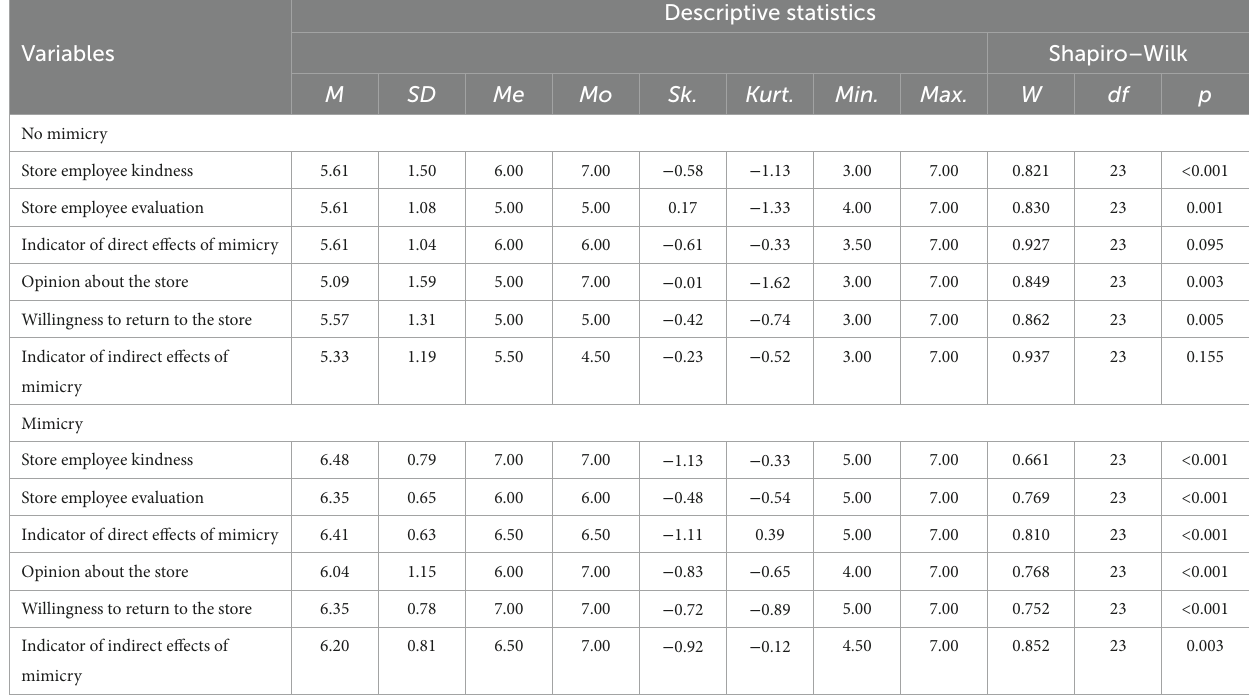
TABLE 1 Descriptive statistics of all study variables within the no mimicry and mimicry group (Pretest).